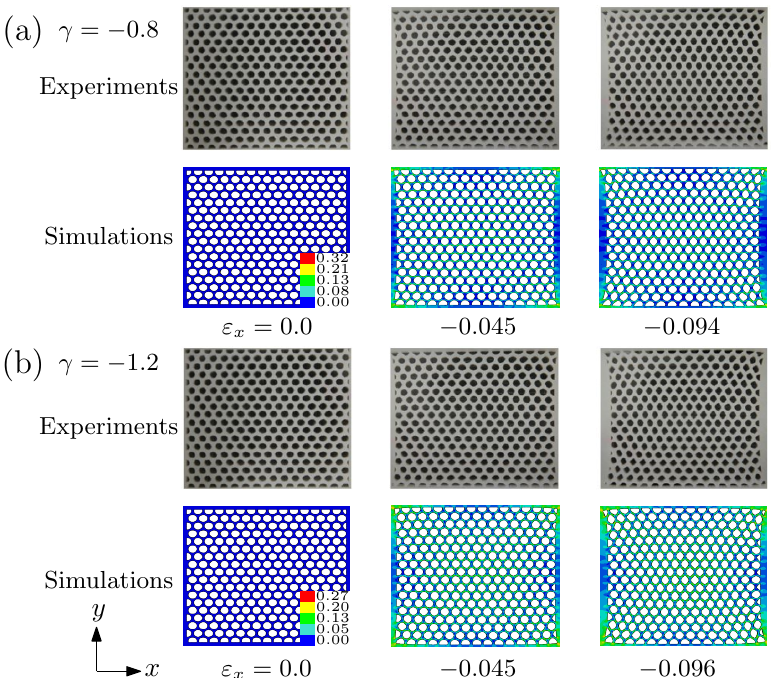
Figure 5. Deformed morphologies of specimen 1 at different applied strains predicted by the simulations and the experiments. ( a ) γ = is imposed.